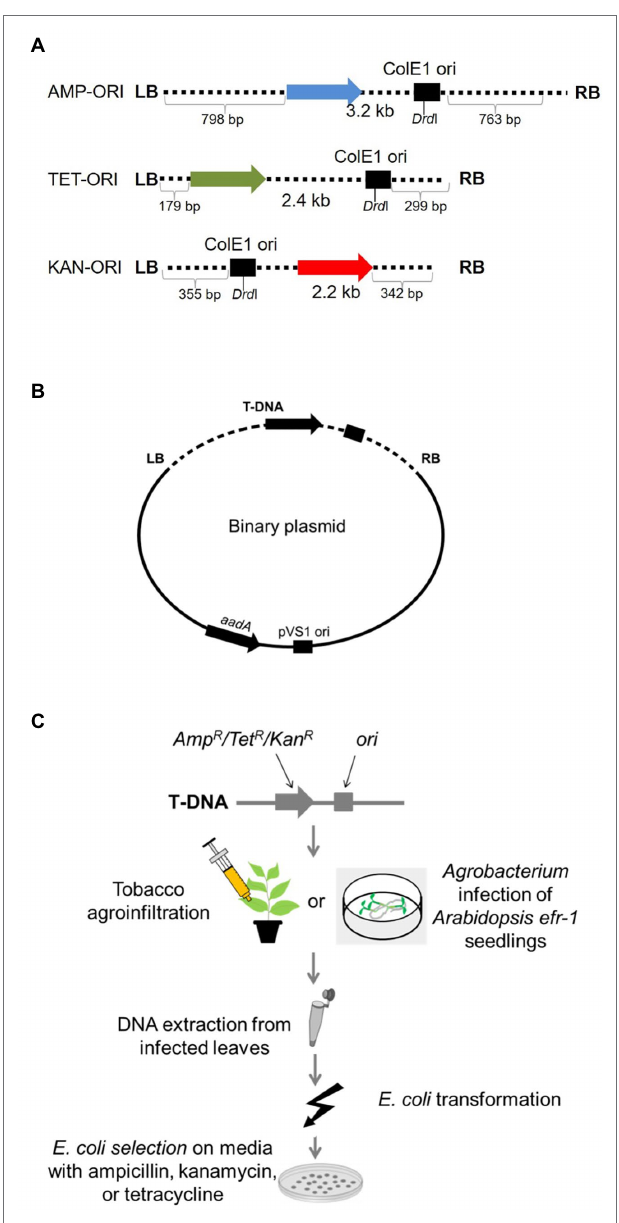
FIGURE 1 | T-circle isolation using “simple” T-circle binary vectors. (A) Schematic diagram of the T-DNA regions of the various T-DNA binary vectors. AMP, TET, and KAN indicated genes encoding ampicillin, tetracycline, and kanamycin resistance, respectively. ORI indicates the ColE1 origin of replication. LB and RB indicate T-DNA left and right borders, respectively. (B) T-DNA binary vectors used in these experiments. aadA indicates a gene encoding spectinomycin resistance. pVS1 ori indicates the origin of replication of the plasmid in Agrobacterium . (C) Schematic diagram of the plant